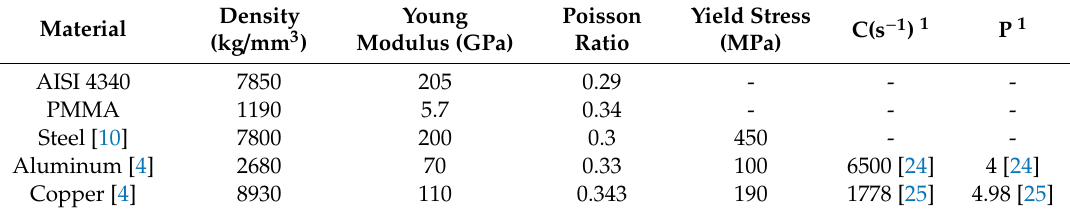
Figure 6. Stress–strain curve for the aluminum and copper foil [4]. Table 3. Mechanical properties of the material used in the